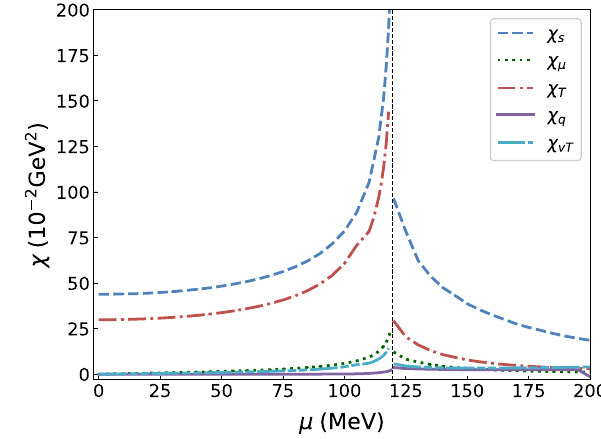
Fig. 2 Five different susceptibilities at T = 120 MeV